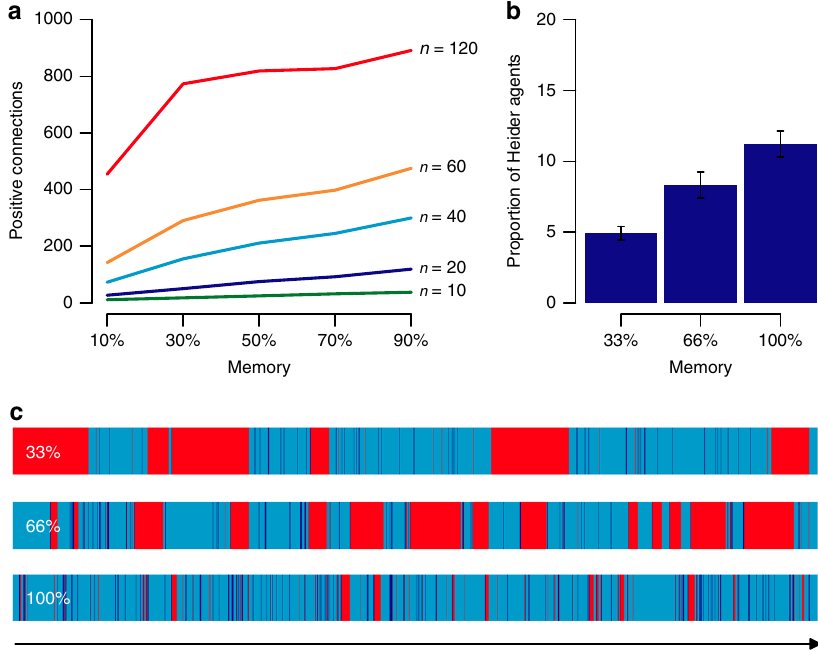
Fig. 6 Reputation and memory. With increased memory capacity (percentage of memorized relationships), reputation sensitive agents establish more cooperative connections ( a ). When under selection pressure, an increase in memory also increases the relative proportion of Heider agents in the population ( b ), which leads to more rapid cycles ( c ) between a population that consists of a majority of friend-focused agents (light blue columns), Heider agents (dark blue columns) and free-riders (red columns) — based on n = 100, 10 5 iterations, i = 10, c = 1, b = 4, r = 0.3. Error bars indicate the standard error of the